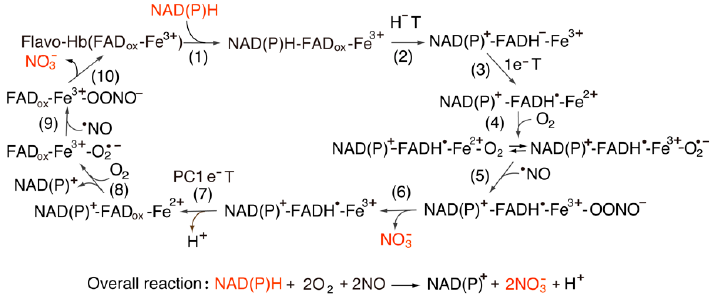
Figure 5. Proposed catalytic cycle for flavohemoglobin.